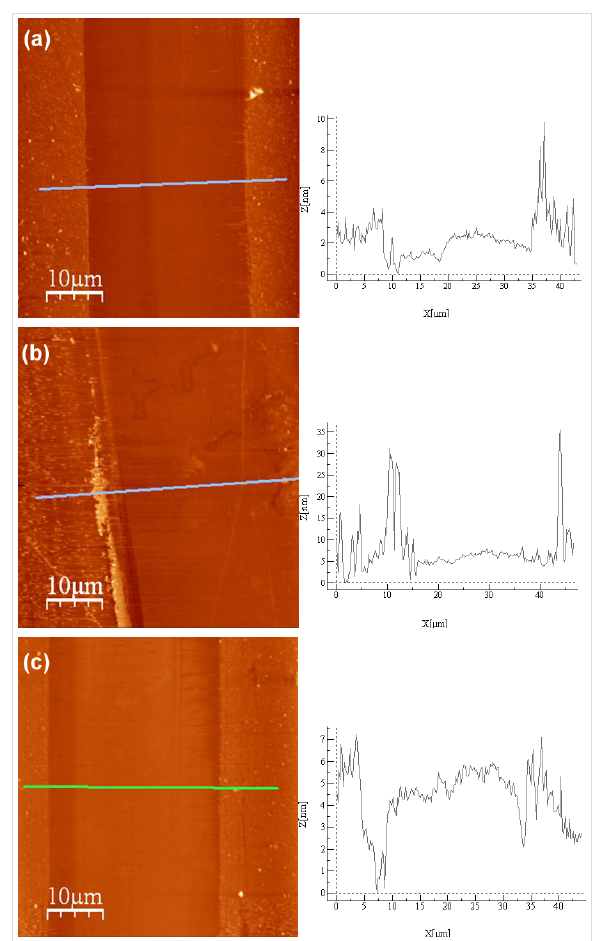
Figure 6: AFM images and height profiles of the sliding tracks in (a) dry PEG, (b) PEG + [EMIM][TfO] and (c) PEG + [EMIM][EtSO 4